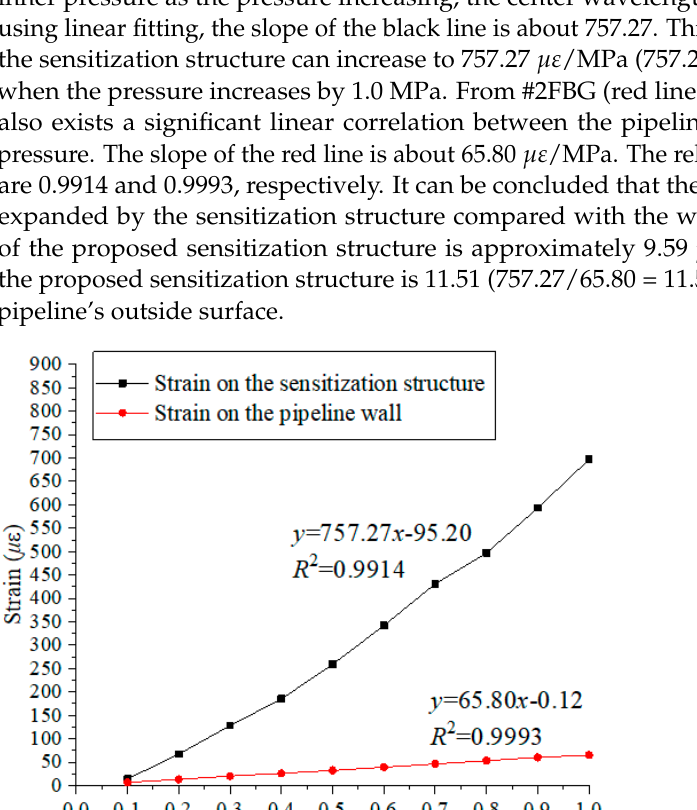
inner pressure as the pressure increasing, the center wavelength gradually increases. By